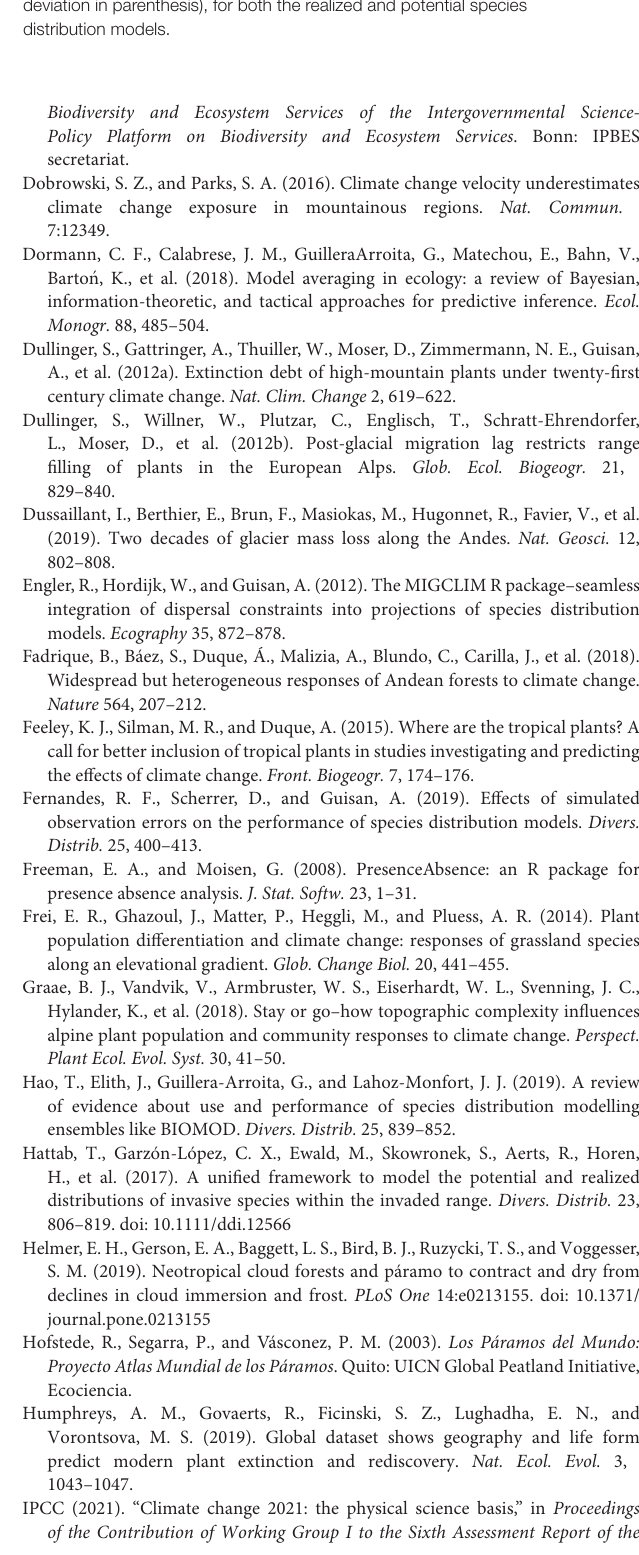
Supplementary Table 1 | Endemic status of the 664 species modeled in the study. The procedure included fitting 90% of the species occurrences (1) in the study area defined by the Latitude-Longitude frame, and (2) above the 3,000 m elevation mask. The table shows each step of the process and the final classification of every species as endemic or not of the high northern Andes.